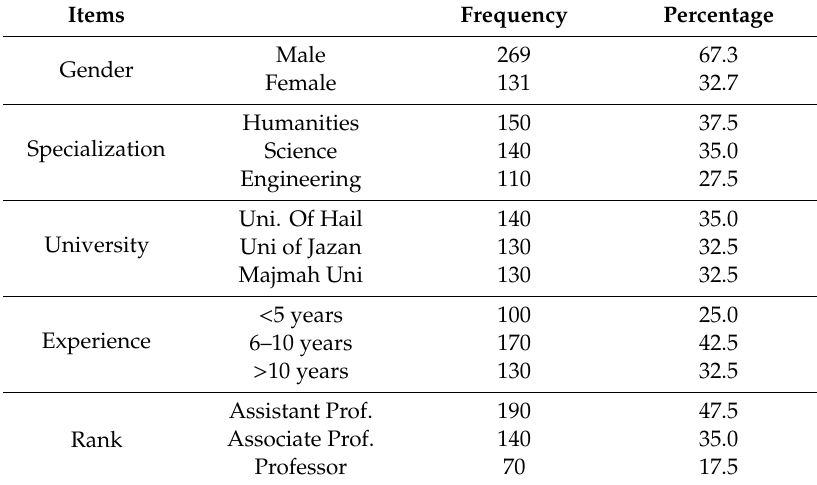
Table 2. Demographic distribution of respondents.